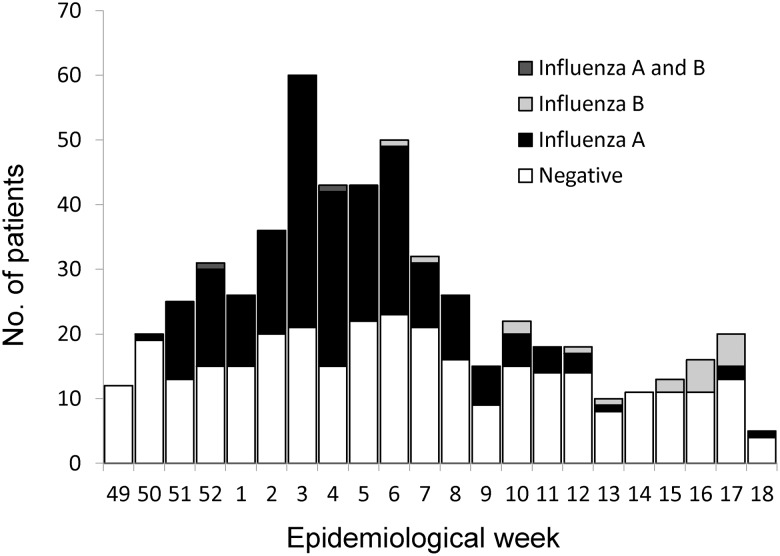
Numbers of influenza positives and negatives by week of hospital visit.